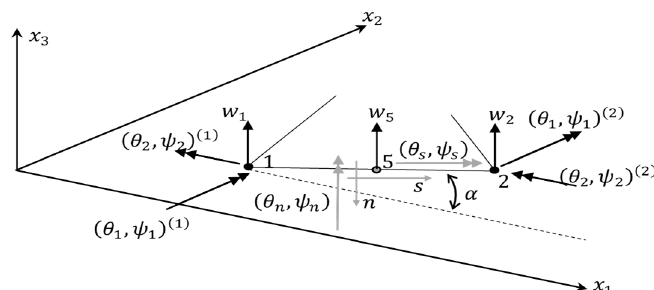
Figure 5. Nodal dof’s (transverse deflection, bending rotations, and zigzag amplitudes) and edge co-ordinate, s.